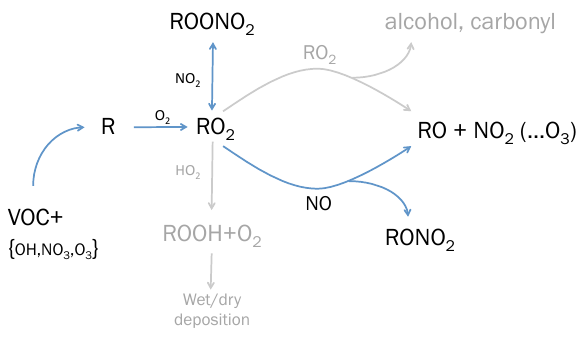
Fig. 1. Schematic of the atmospheric O 3 -NO x -hydrocarbon chemistry cycle studied by BORTAS.